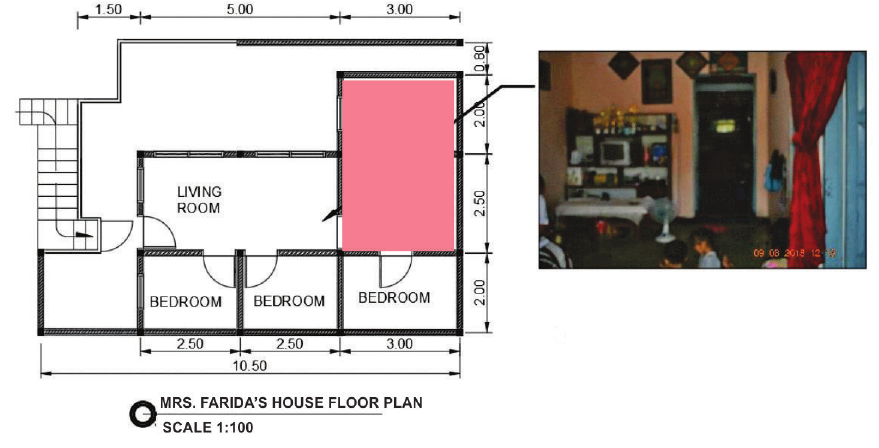
Figure 6. Red Space as a mix-use space used by Gender in Mrs. Faridah’s house (Case 4)